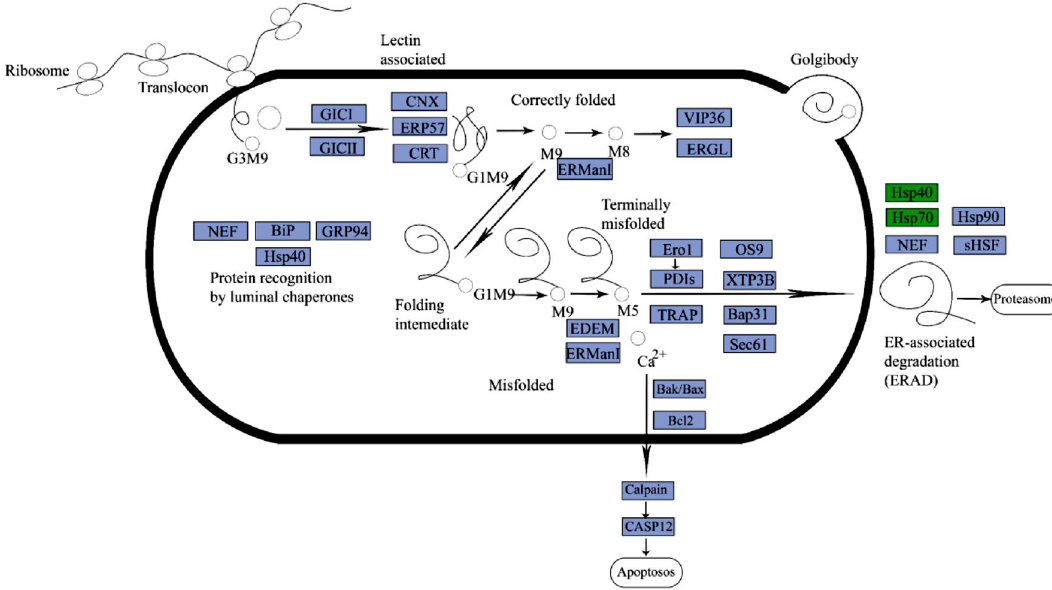
Figure 5. Protein processing in the endoplasmic reticulum at high altitudes (The purple boxes represent enzymes or genes, green box represent down-regulated). The pathway was visualized by the Adobe Illustrator software (https:// www. adobe. com/ cn/ produ cts/ illus trator.